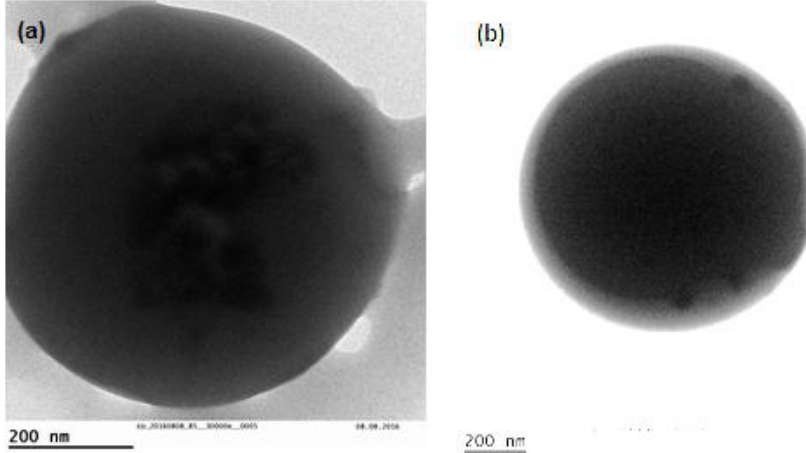
Figure 7. TEM images of microspheres: ( a ) Thiolated_PLA_MCF_Pal and ( b ) Thiolated_PLGA75/ 25_MCF_Pal.